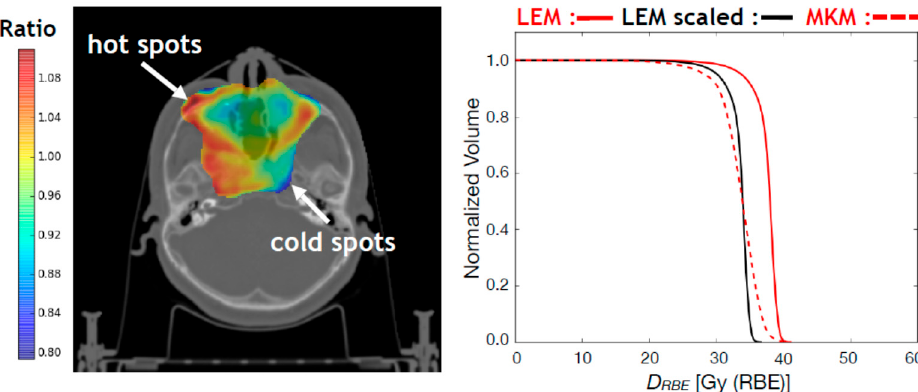
Figure 6. Left panel: ratio between FRoG-calculated MKM D RBE and LEM D RBE multiplied by the clinical scaling value (see the next for more details) for the 12 C ion patient shown in Figure 4. Only the values for the CTV are displayed. Right panel: FRoG-calculated LEM and MKM D RBE VH for the CTV are displayed with a red solid line and red dashed line, respectively. The D RBE VH for the LEM D RBE values rescaled by the clinical scaling factor is displayed with a black solid line.